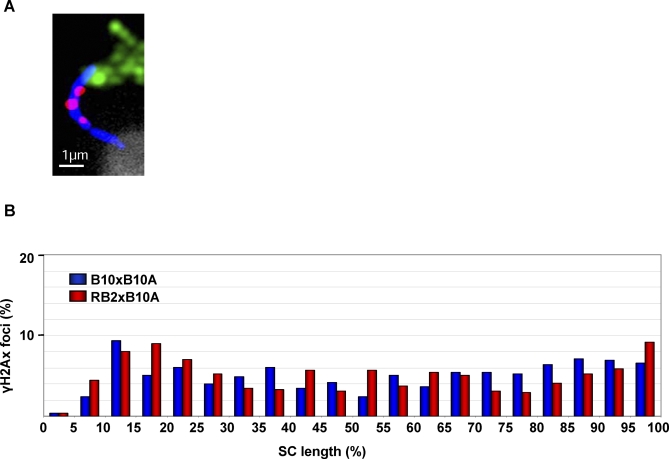
Different Distributions of γH2AX Foci on Chr 17 in B10xB10.A and RB2xB10.A(A) Chr 17 of a pachytene spermatocyte labeled with SYCP3 (blue), γH2AX (red), Chr 17 probe (mix of BACs RP23-10B20, and RP24-67L15; green), and stained with DAPI (white).(B) Percentage of γH2AX foci per 5% SC intervals on Chr 17 in B10xB10.A and RB2xB10.A hybrids (n = 549 and 513 foci, respectively).